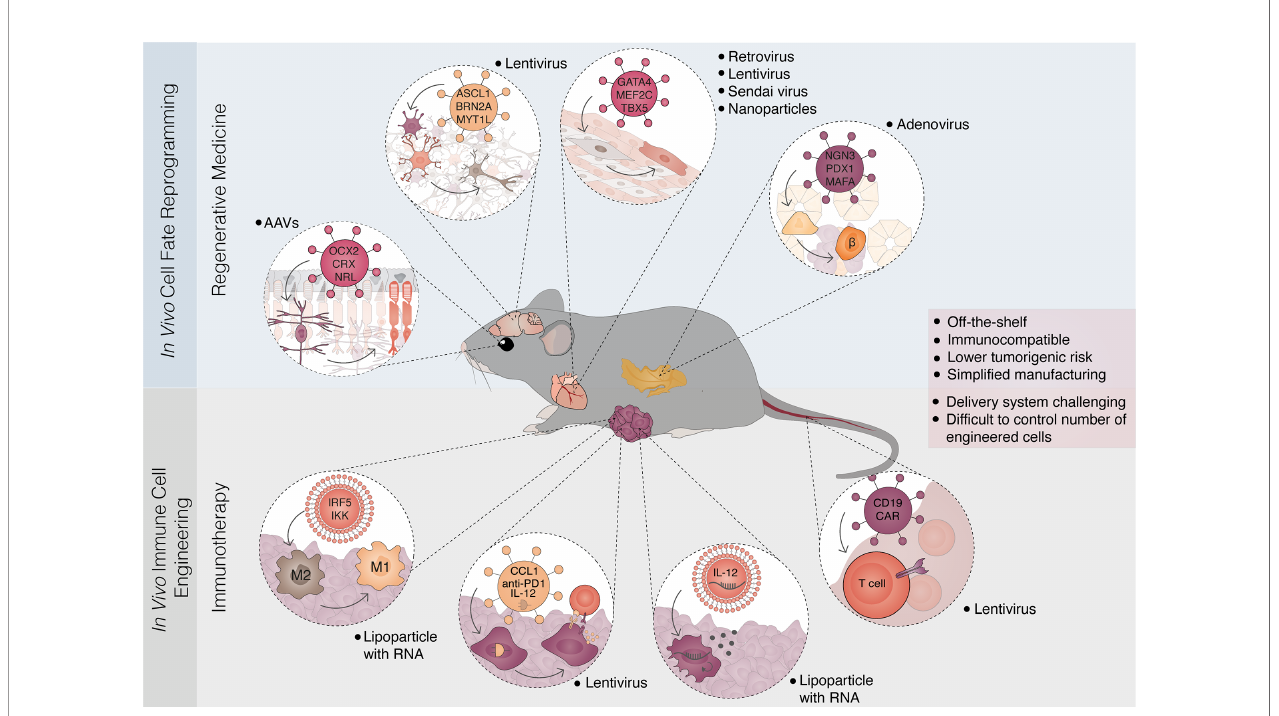
FIGURE 4 | In vivo reprogramming strategies for regenerative medicine and immunotherapy. Overview of parallel in vivo approaches for cell fate reprogramming and immune cell engineering. In vivo cell fate reprogramming offers an approach to restore damaged cell types and tissue function (top panel). The concept has been demonstrated in multiple tissues and cellular conversions. Examples include the reprogramming of Müller glia cells to photoreceptors leading to restoration of vision in congenitally blind mice; reprogramming of astrocytes and glial cells to neurons; the conversion of fi brotic tissue after myocardial infarction to functional cardiomyocytes and the reprogramming of pancreatic acinar/exocrine cells into insulin-producing b -cells. These strategies mainly rely on the delivery of lineage- speci fi c factors through viral vectors. In parallel, in vivo engineering of immune cells has been developed allowing the generation of genetically modi fi ed immune cells, often designated immune reprogramming (bottom panel). Recent examples in cancer immunotherapy include the conversion from macrophage type 2 (M2) to macrophage type 1 (M1), manipulation of cancer cells to express immunogenic circuitry and cytokines, and the in vivo delivery of chimeric antigen receptors (CAR) to circulating T-cells. Delivery strategies are diverse including lipid nanoparticles coupled with DNA or replicative RNA, and viral vectors (lentivirus, AAV, retrovirus, adenovirus, Sendai virus). In vivo approaches in regenerative medicine and immunotherapy converge towards the creation of off-the-shelf, immunocompatible therapies that harbor low tumorigenic risks. Simpli fi ed clinical translation and manufacturing are balanced by challenges in delivery and the control of cell-type speci fi city and numbers. AAV, adeno-associated